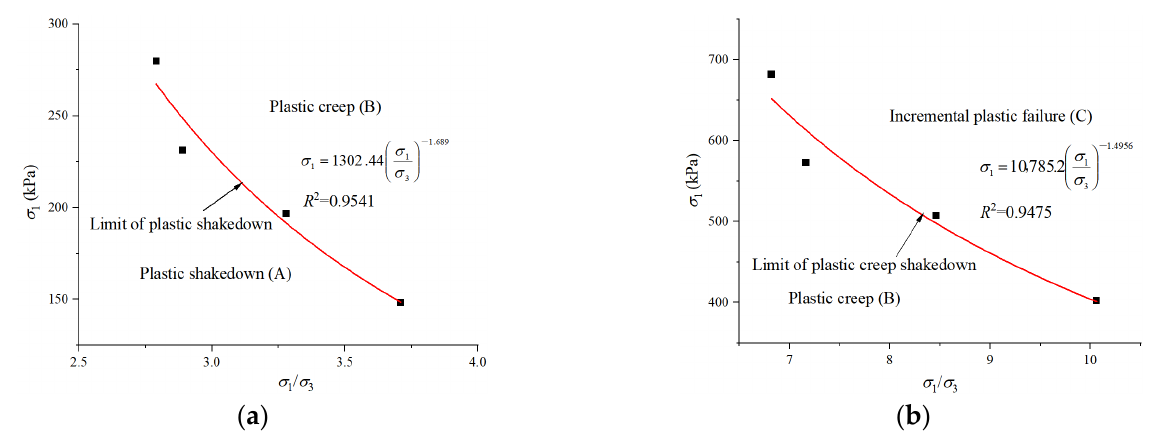
Figure 16. Fitting results of critical stress of calcareous sand: ( a ) Fitting under plastic shakedown; ( b ) Fitting under plastic creep.